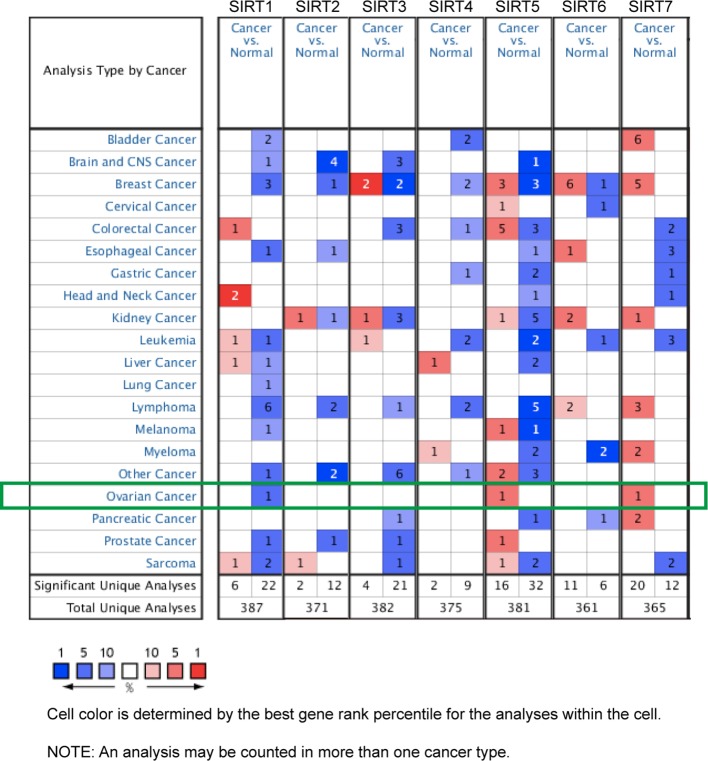
The mRNA levels of sirtuins (SIRTs) in 20 different types of cancers (Oncomine). The number in each cell represents the number of analyses that satisfied the following threshold: P < 0.05, the absolute value of log2 fold change >1.5, and gene rank, 10%. The numbers in colored cells show the quantities of datasets with statistically significant mRNA overexpression (red) or downexpression (blue) of target genes.